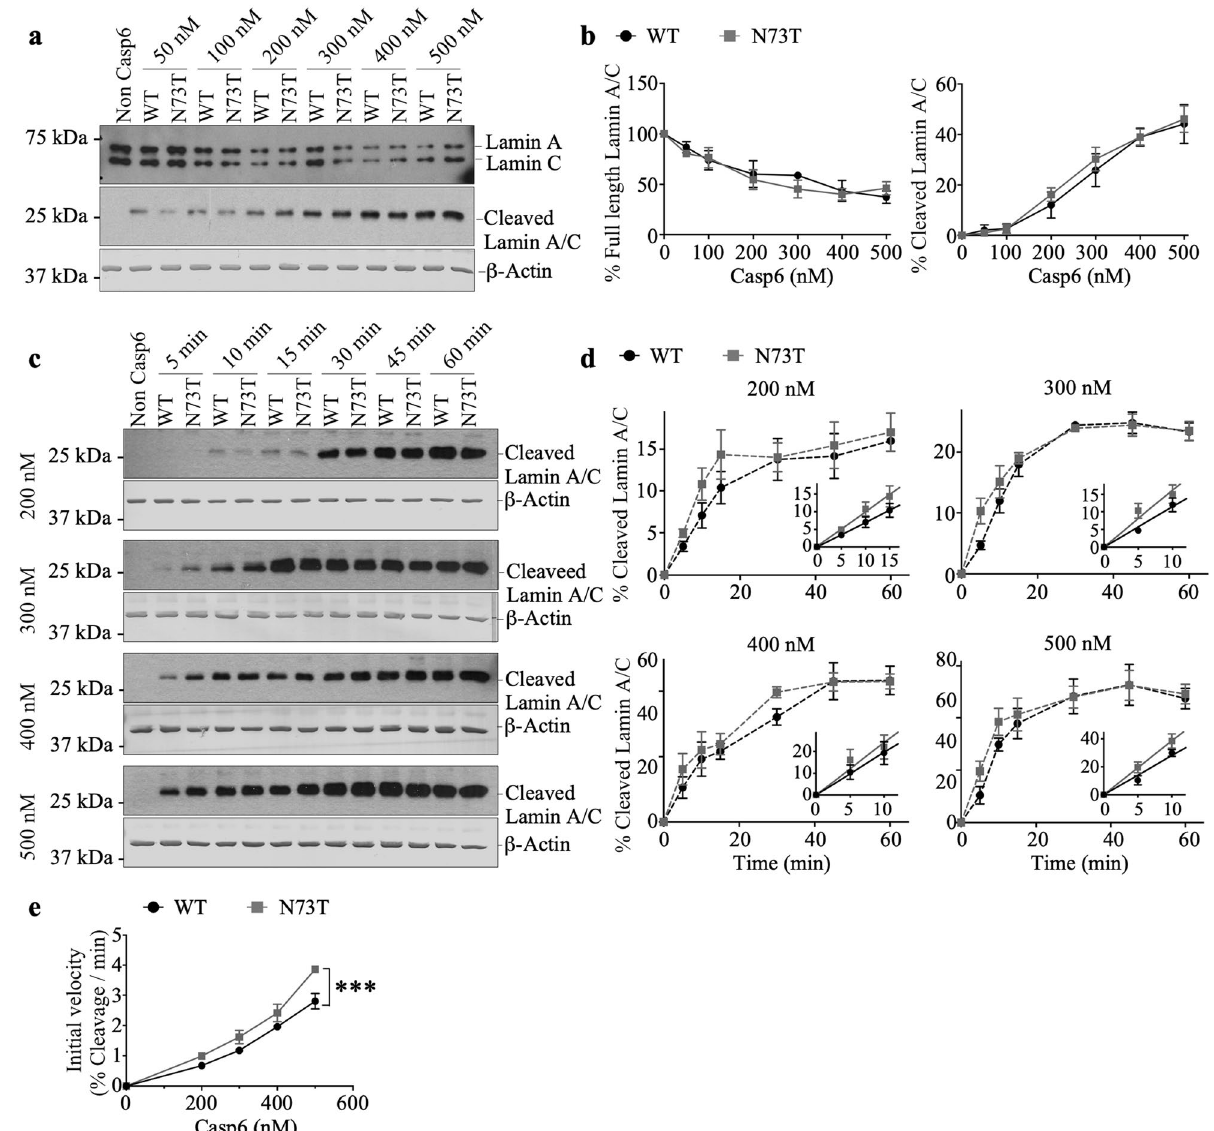
Figure 4. Casp6WT and Casp6N73T enzymatic processing of Lamin A/C. ( a ) Western blot of full-length (#2032 Cell Signaling Technology; top) or cleaved Lamin A/C at VEID (neoepitope antibody #2035 Cell Signaling Technology; middle) and β-Actin (bottom) from 50–500 nM recombinant Casp6WT or Casp6N73T incubated with Casp6 knockout mouse tissue nuclear extracts. ( b ) Quantification of full-length Lamin A/C and cleaved Lamin A/C by Casp6WT or Casp6N73T expressed as % of the control with no added recombinant active Casp6. ( c ) Western blots of time-dependent cleaved Lamin A/C by 200, 300, 400, or 500 nM Casp6WT or Casp6N73T incubated with Casp6 knockout tissue extracts. ( d ) Quantification of time-dependent generated cleaved Lamin A/C by Casp6WT or Casp6N73T shown in ( c ) expressed as % of the control with no added recombinant active Casp6. Insets: The initial velocity phase of the cleavage curve. The linear regression was performed on % cleaved Lamin A/C at 5, 10, and 15 min by 200 nM Casp6 (WT: R 2 = 0.82, N73T: R 2 = 0.82), or on % cleaved Lamin A/C at 5 and 10 min by Casp6 with 300 nM (WT: R 2 = 0.88, N73T: R 2 = 0.80), 400 nM (WT: R 2 = 0.71, N73T: R 2 = 0.66), or 500 nM (WT: R 2 = 0.90, N73T: R 2 = 0.90). ( e ) The initial velocity of Casp6WT and Casp6N73T reacting on Lamin A/C measured from ( d ). Data were shown as mean ± s.e.m from 3 independent experiments. Statistical evaluations were done with two-way ANOVA (variant: p = 0.0001, concentration: p < 0.0001, interaction: p = 0.1329). Post-hoc analyses were done with Tukey’s test. ***p < 0.001 N73T vs WT. Full-length images of blots/gels are presented in Supplementary